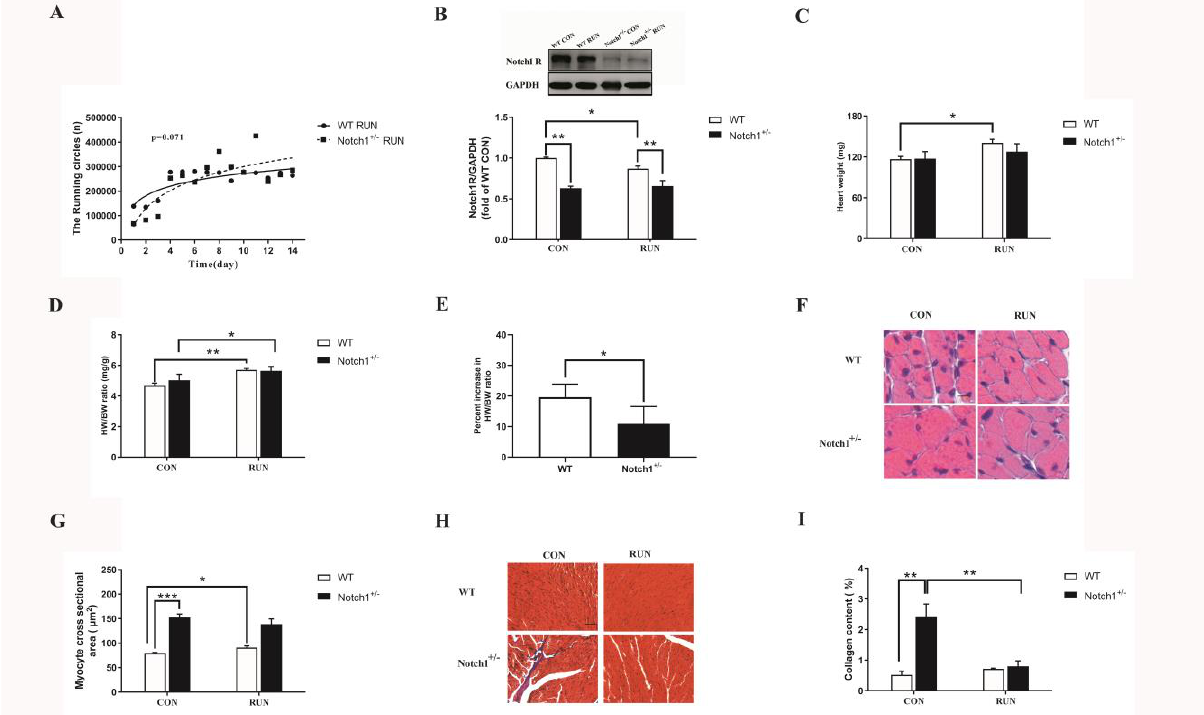
Figure 1. ( A ): The running circles of WT RUN group (n = 8) and Notch1 +/− RUN group (n = 6); ( B ): The Notch1 expression (n = 4); ( C ): Heart weight (mg) (n = 6 – 8); ( D ): HW/BW ratio (mg/g) (n = 6 – 8); ( E ): the percent increase in HW/BW ratio; ( F ): The representative optical microscope photographs of cardiomyocytes (scale bar = 10 μm); ( G ): the myocyte cross-sectional area (n = 4); ( H ): The representative photographs of Masson staining (scale bar = 20 μm) ; ( I ): the collagen content (n = 4). WT CON: wild-type control mice; WT RUN: wild-type running mice; Notch1 +/− CON: Notch1 heterozygote deficient control mice; Notch1 +/− RUN: Notch1 heterozygote deficient running mice. Data are expressed as mean ± S.E.M. * p < 0.05, ** p < 0.01, *** p < 0.001.